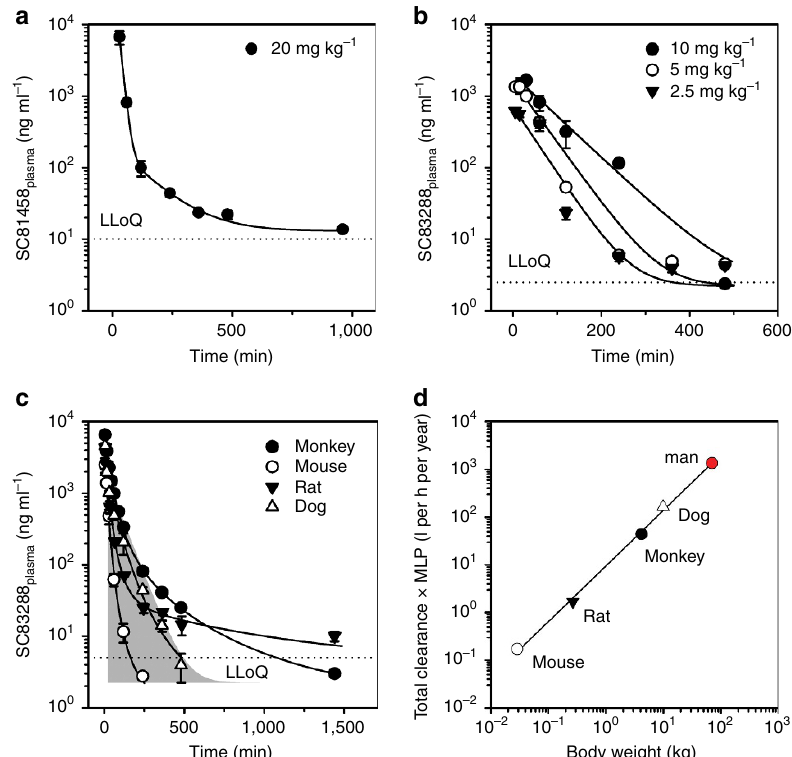
Figure 7 | Pharmacokinetic profiles of SC81458 and SC83288. ( a , b ) Mean plasma concentration of SC81458 ( a ) and SC83288 ( b ) over time following i.p. administration of the indicated doses in mice. ( c ) Mean plasma concentration of SC83288 over time following i.v. administration of 2mgkg (cid:2) 1 in monkeys (closed circles), mice (open circles), and rats (closed inverted triangles) and of 1.7mgkg (cid:2) 1 in dogs (open triangles). For comparative reasons, the SC83288 AUC of the i.p. 10mgkg (cid:2) 1 treatment group in mice is indicated in grey. The dotted lines show the lower limit of quantification (LLoQ). The mean ± s.e.m. are shown for at least three animals. Data were examined using a non-compartment analysis (NCA) and relevant PK parameters are